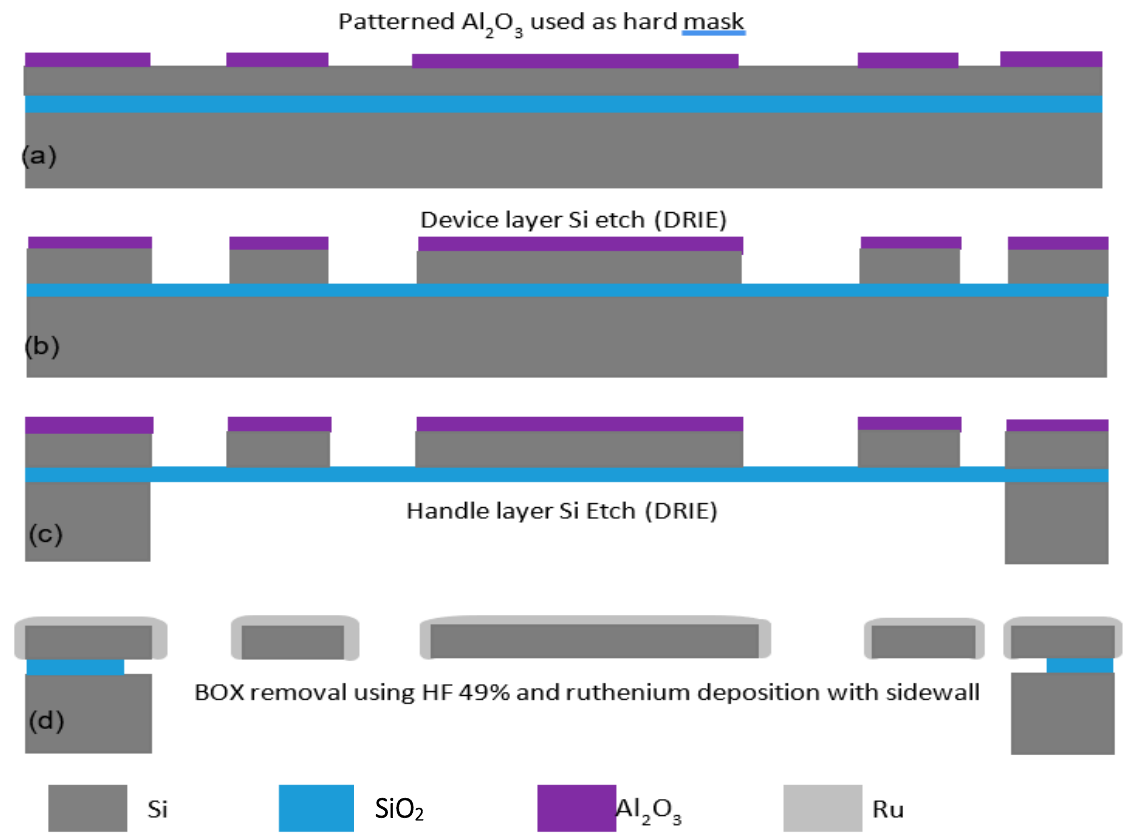
Figure 10. Schematic side view showing the microfabrication process flow: ( a ) Patterned Al2O3 used as hard mask, ( b ) Device layer etch (DRIE) ( c ) Backside etch (DRIE) ( d ) Oxide etch in HF followed by ruthenium deposition with sidewall coverage.